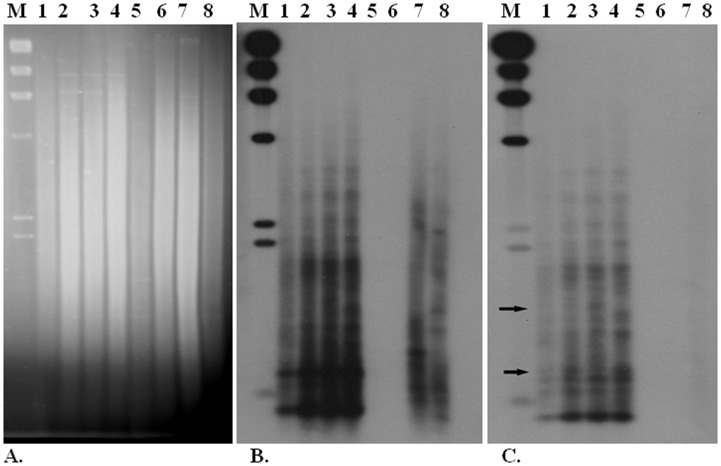
Southern hybridization of various silkmoths using a putative transposable element amplicon from A. assamensis as probe.Genomic DNAs (A) of A. assamensis moths BK12 (lane 1), TR3 (lane 2), TR4 (lane 3), KG8 (lane 4); B. mori (lane5), S. cynthia (lane 6), A. mylitta (lane 7) and A. proylei (lane 8) were digested with Hae III. Southern hybridization of the digested DNAs with an 800 bp amplicon containing a putative mariner-like element are shown after (B) a low stringency wash and (C) a high stringency wash. Lane M shows λ DNA restricted with Hind III as a size marker. Arrows denote hybridization signals that distinguish moths from different populations.